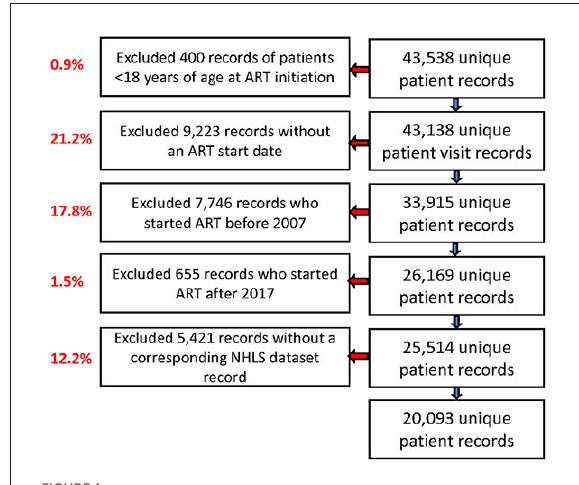
FIGURE1 Study flow chart showing the selection process of ART patients records from Themba Lethu Clinic (TLC) and National Health Laboratory Service (NHLS) laboratory record data from the NHLS National HIV Cohort.